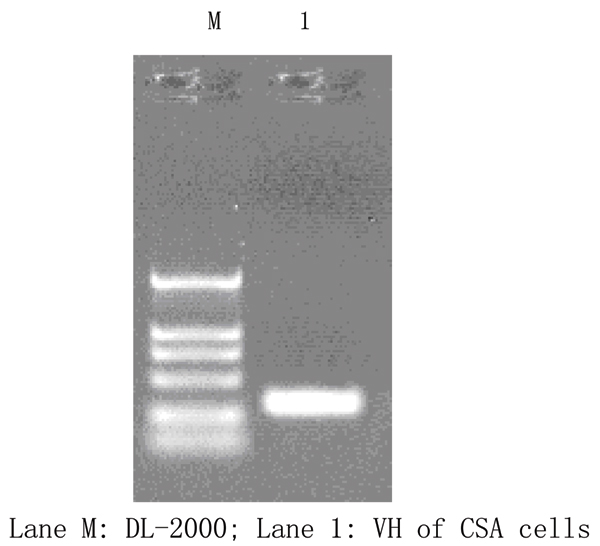
PCR amplification of the VH region of CSA. Lane M: DL-2000; Lane 1: VH of CSA cells.